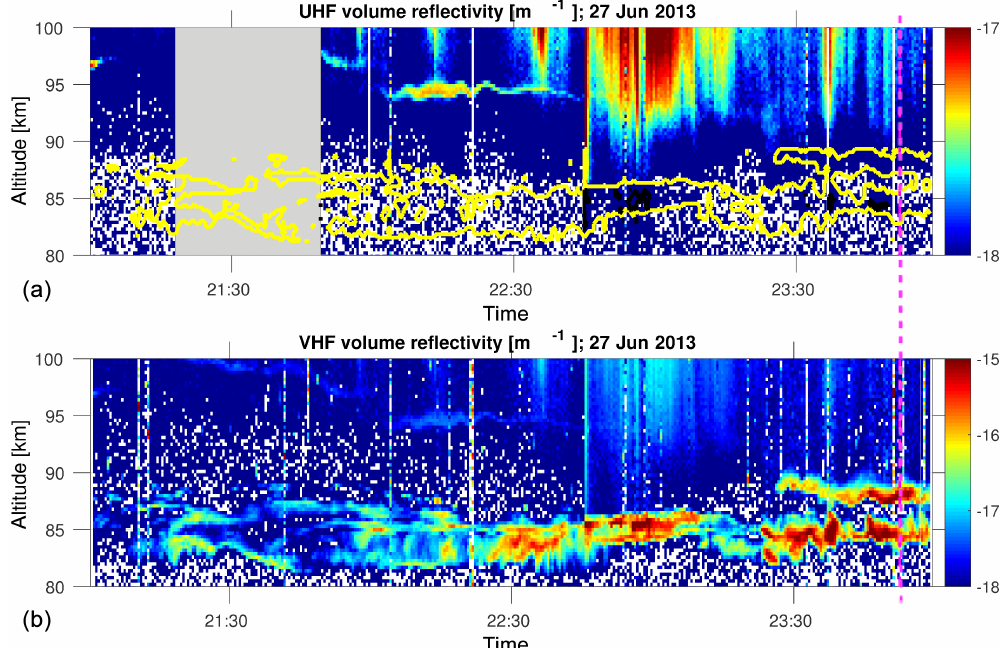
Figure 6. EISCAT measurements in terms of radar reflectivity. The upper and lower panel show UHF and VHF data, respectively. Yellow contours in the UHF plot mark regions where the VHF radar observed PMSEs. Note the different scales of the